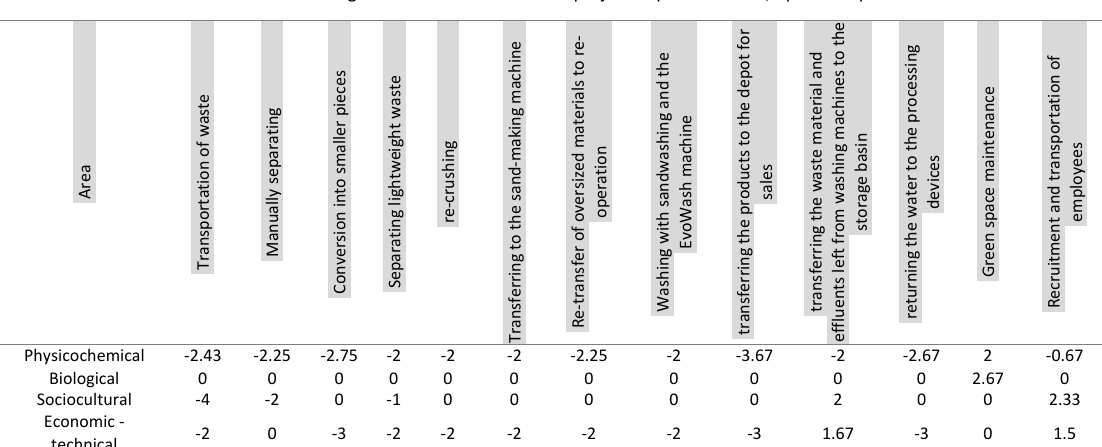
Table 5: The average environmental effects of project implementation, operation phase